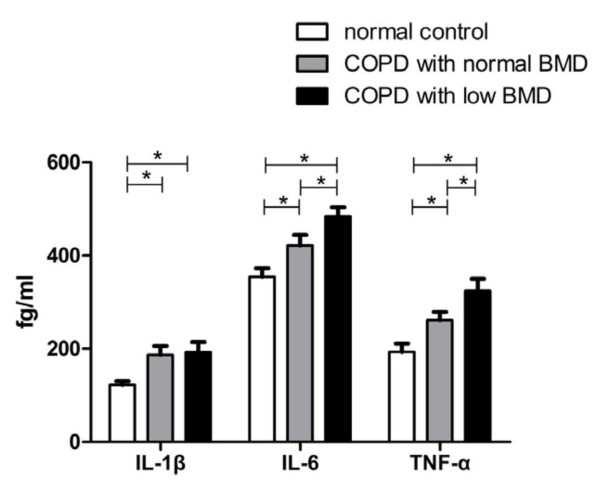
Comparison of serum IL-1β, IL-6, TNF-α levels among three groups. *p < 0.05. Abbreviations: IL: interleukin, TNF-α: tumor necrosis factor α.